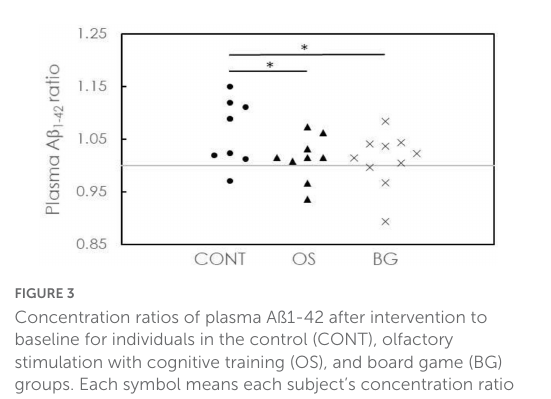
FIGURE2 Concentration ratios of plasma Tau after the intervention to baseline for individuals in control (CONT), olfactory stimulation